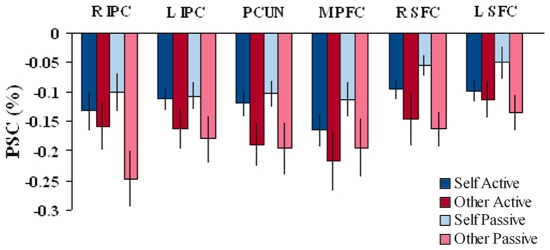
BOLD activations in the intrinsic ROIs by response type and movement authorship.Average BOLD activations in the ROIs for the four cells resulting from crossing the respond self vs. respond other conditions and the active vs. passive conditions. Note the similarity of responded self vs. responded other differences in the active and passive conditions. Error bars =  SEM.